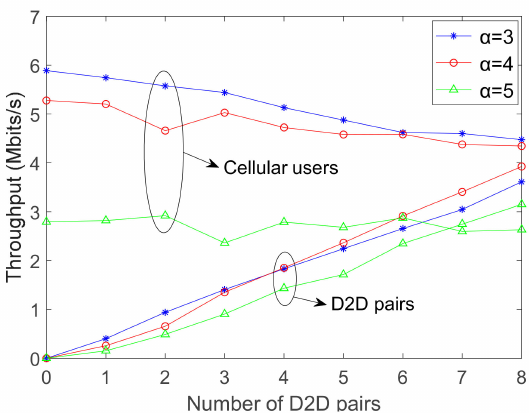
Figure 7. Throughput of D2D pairs in di ff erent uplink states for proposed WE-I-A algorithm.